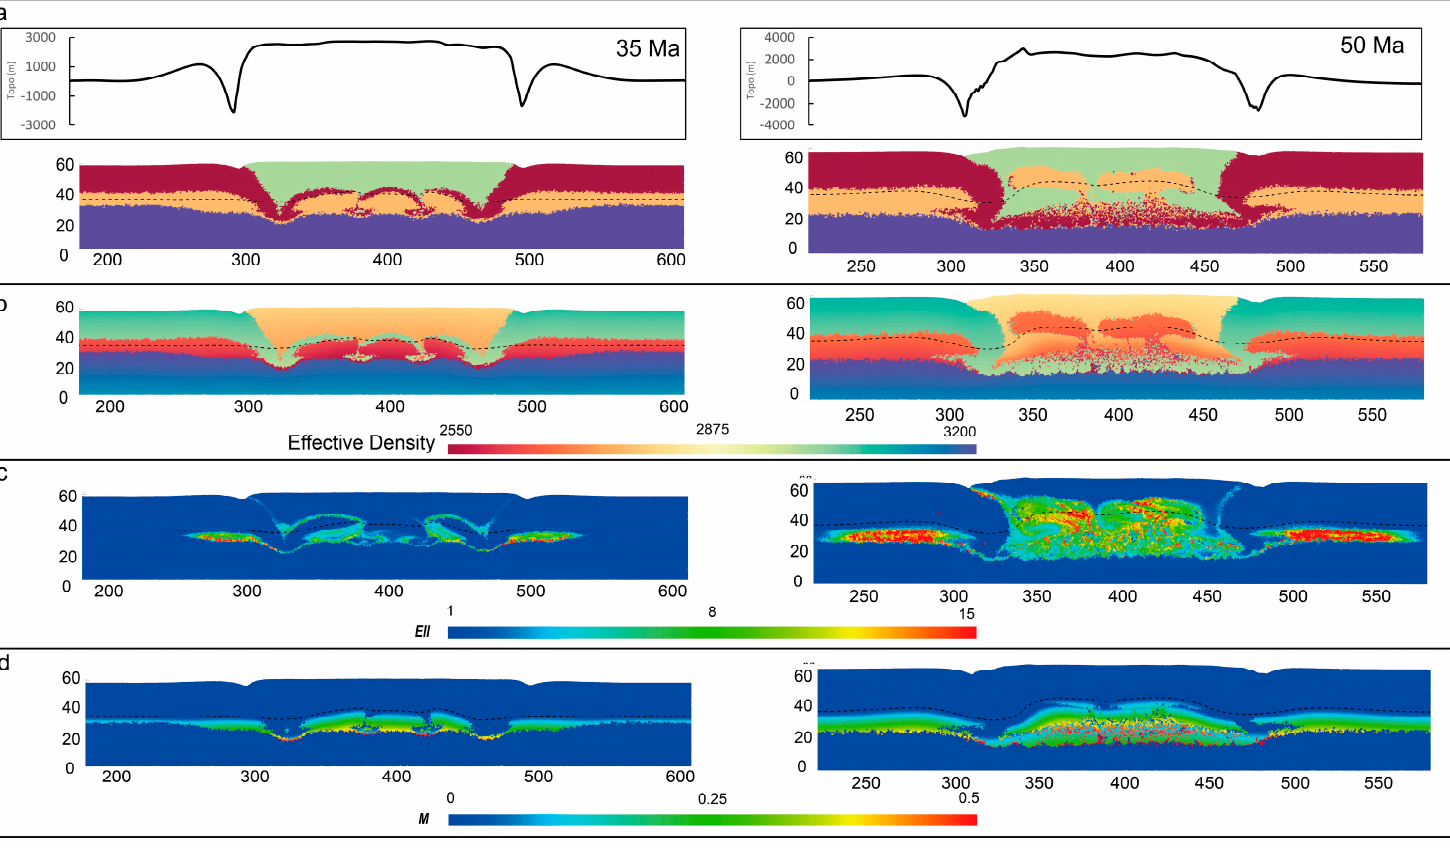
ε II · ∆ t ). ( d ) Melt fraction is obtained by 0